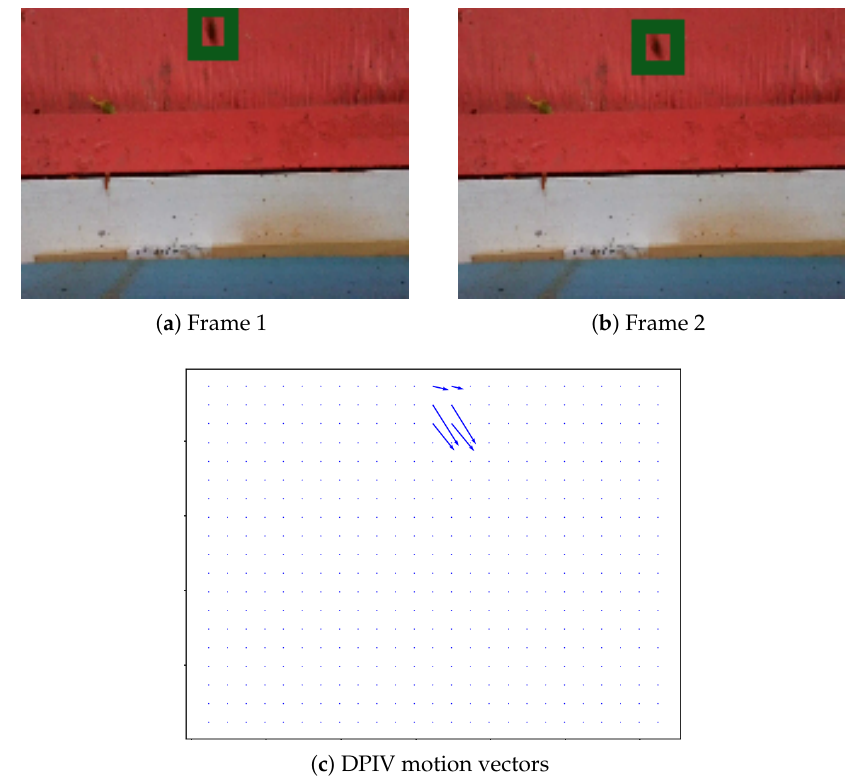
Figure 6. Two consecutive video frames, Frame 1 and Frame 2 with a single moving bee and corresponding DPIV motion